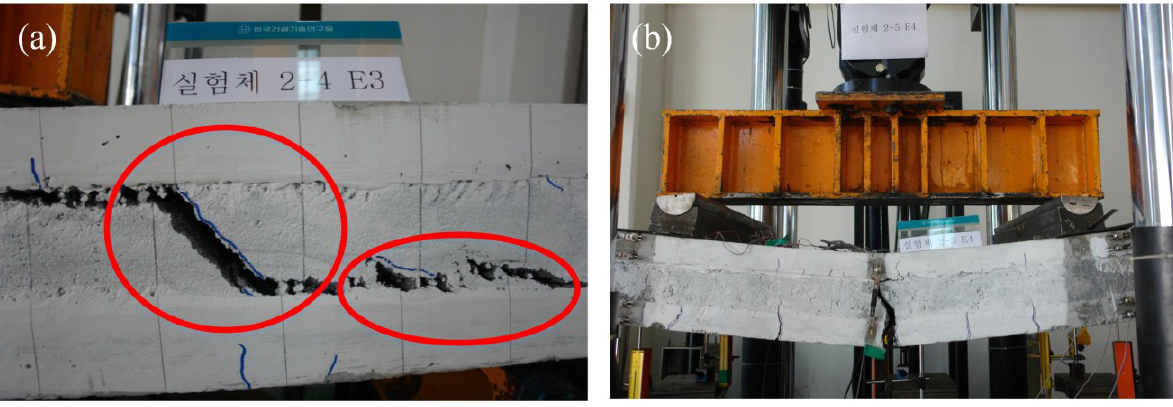
Figure 8. Failure modes of the specimen using EPS insulation: ( a ) shear failure of EPS insulation; ( b ) reinforcement rupture in the EPS4